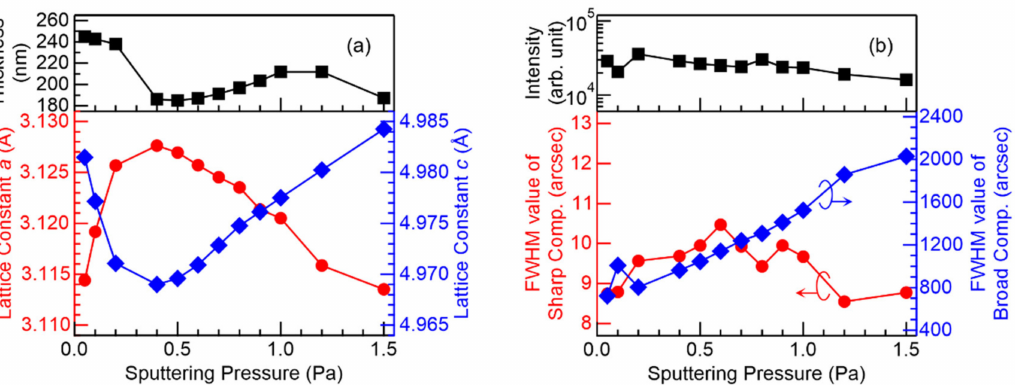
Figure 6. ( a ) Thicknesses of AlN films sputtered at various sputtering pressures, and effect of sputtering pressure on lattice constants a and c of the as-sputtered AlN film. ( b ) Effect of sputtering pressure on the peak intensity of the sharp component, and XRC-FWHM values of the sharp and broad components in the AlN(0002)